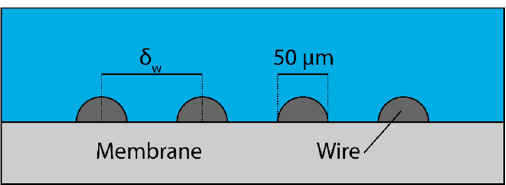
Figure 6. Baffling geometry that was used to reduce concentration polarization on the surface of membranes. of